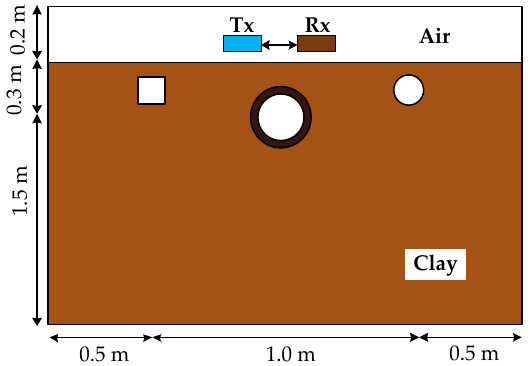
Figure 16. Schematic diagram of complex underground cavity model.